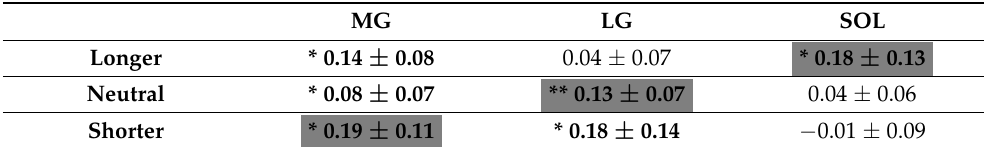
Table 3. Stepwise regression model to identify possible predictors of the relative variability for torque (T CoV ) out of the relative variabilities for EMG burst (MG CoV , LG CoV , and SOL CoV ) across the contraction levels at each ankle joint angle. Data are shown as the estimated coefficient ± 95% confidence interval. The significant predictors are in boldface type and the most important variable is highlighted. * p < 0.05. ** p < 0.001.